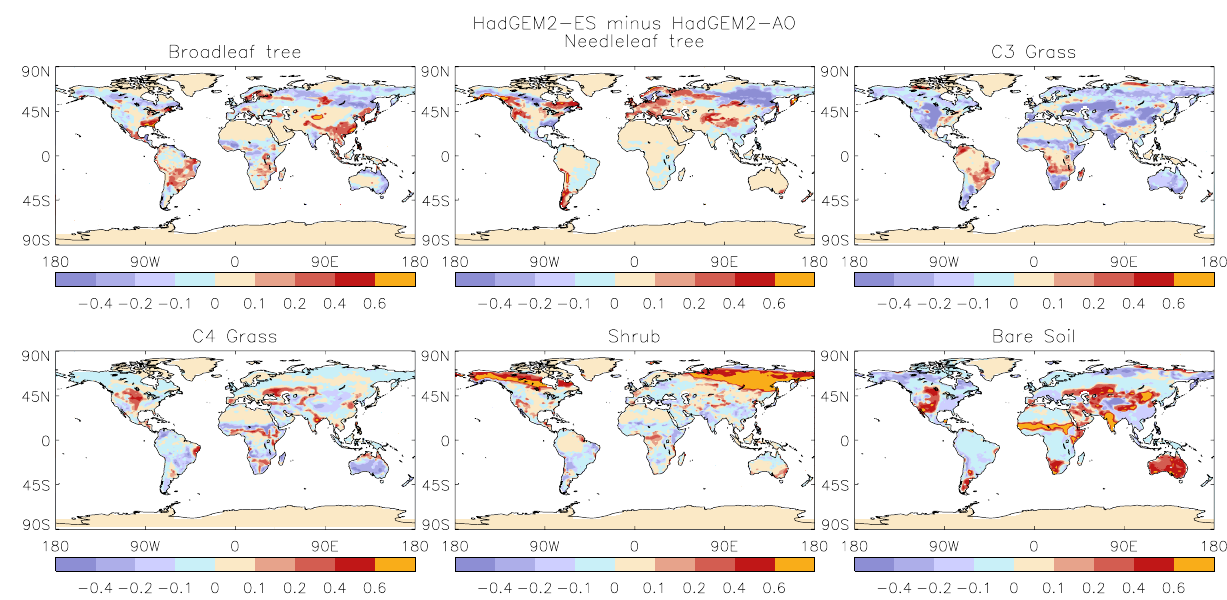
Fig. 4. Differences in present-day (1980–2005) land cover type between HadGEM2-ES and HadGEM2-AO.